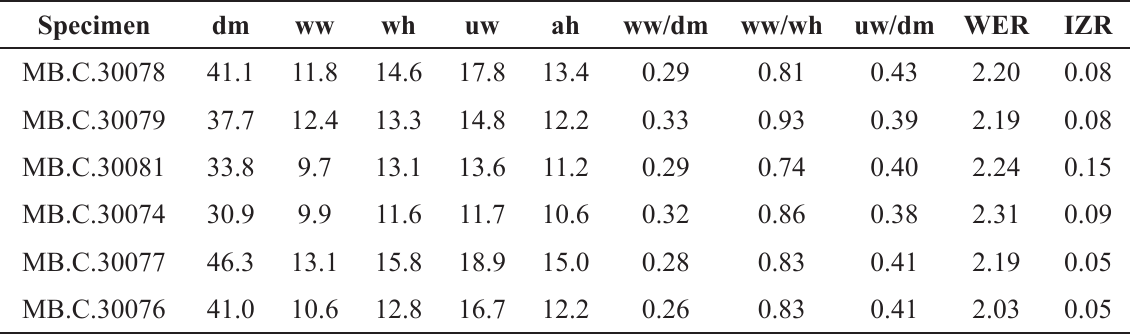
Table 33. Conch dimensions (partly estimated) and ratios of selected specimens of Abichites stoyanowi (Kiparisova in Voinova et al. , 1947) from Baghuk